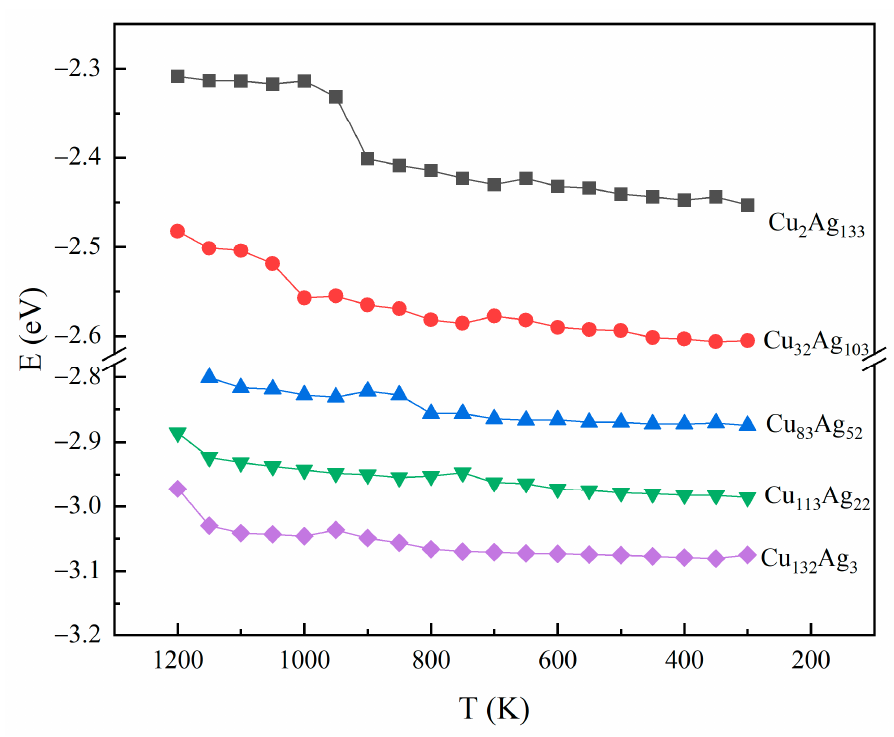
Figure 3. Variation of potential energy per atom of five clusters. Figure 4 shows the packing structures of Cu 2 Ag 133 , Cu 32 Ag 103 , Cu 83 Ag 52 , Cu 113 Ag 22 , and Cu 132 Ag 3 clusters at different temperatures. In the figure, silver atoms are marked in silvery grey and copper atoms in orange. For the Cu 2 Ag 133 cluster at 850 K, it transforms from icosahedral structure to “five-fold twins” structure, where the atoms in different regions are face-centered cubic (FCC) packing, and they have commonly atomic arrange- ments in their interface. In Figure 5a, for the internal cross-section image of this cluster at this temperature, the atoms in face-centered cubic (FCC) packing is represented by green, the interfacial atoms in hexagonal close-packed structure (HCP) red, and the other structures gray for these atoms in the surface. When the temperature decreases to 800 K, this cluster changes from the α packing structure to a Ih structure. At 300 K, the cluster still remains the Ih structure. It can be noted that although this structure is more compact compared to that at 800 K, the outer shell of the cluster shows defects. The Cu 32 Ag 103 cluster is disordered at 1200 K, and there are still many local structures in different small parts at 650 K. At 600 K, the Cu atoms in the cluster’s inner part are arranged into incom- plete icosahedral structure, while the Ag atoms are wrapped around the Cu atoms to form outer shells. When the temperature drops to 300 K, the Cu atoms in the center of this cluster are arranged more compactly. As for the Cu 83 Ag 52 cluster, the overall cluster shows contraction at 1200 K down to 850 K, and transforms to Ih structure at 800 K, where the Ag atoms are loosely arranged in the outer shell. At 300 K, the cluster is still the Ih structure, and some Cu and Ag atoms interchange their positions. The Cu 113 Ag 22 cluster transforms into the α ’ packing structure at 600 K. From Figure 5b, it can be seen that the α ’ packing structure is mainly composed of FCC and HCP structures, but they are not symmetrically arranged, which is somewhat different from the α packing structure. Cu 132 Ag 3 nanoalloy has a layered arrangement stacking structure at 950 K, most of the atoms of the β packing structure are in FCC structure and a few atoms are in HCP structure as seen from Figure 5c. When the temperature decreases to 900 K, the clusters change from β packing structure to the Ih packing structure, and this cluster keeps the Ih structure until room